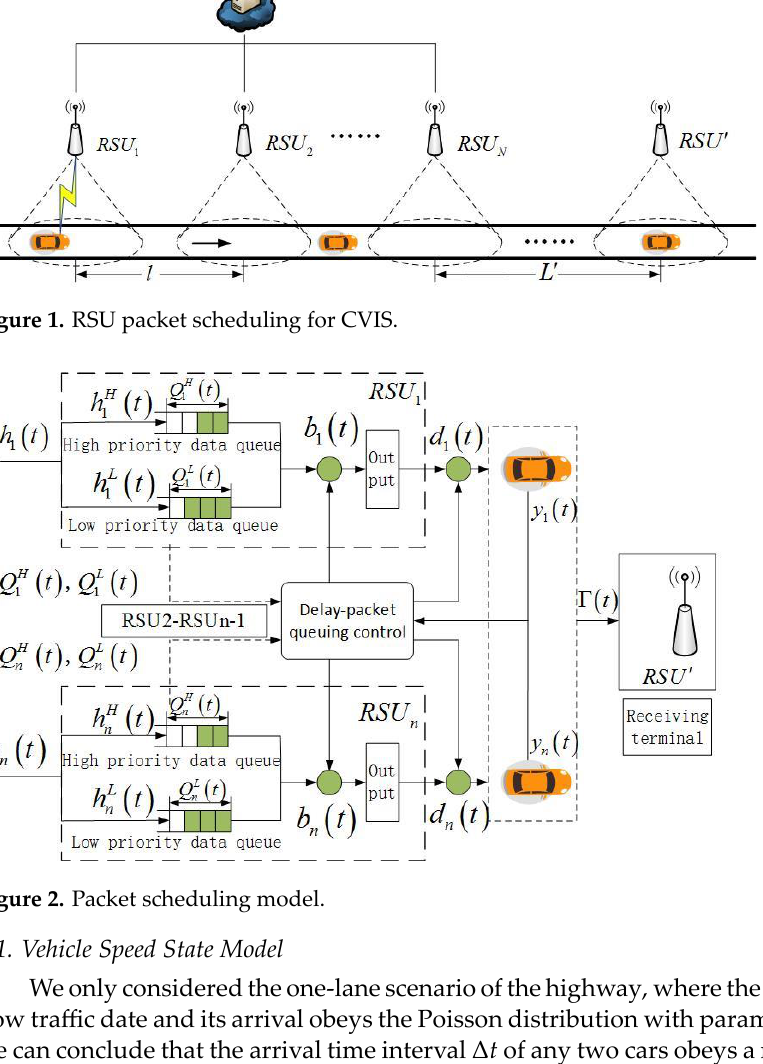
Figure 1. RSU packet scheduling for CVIS.